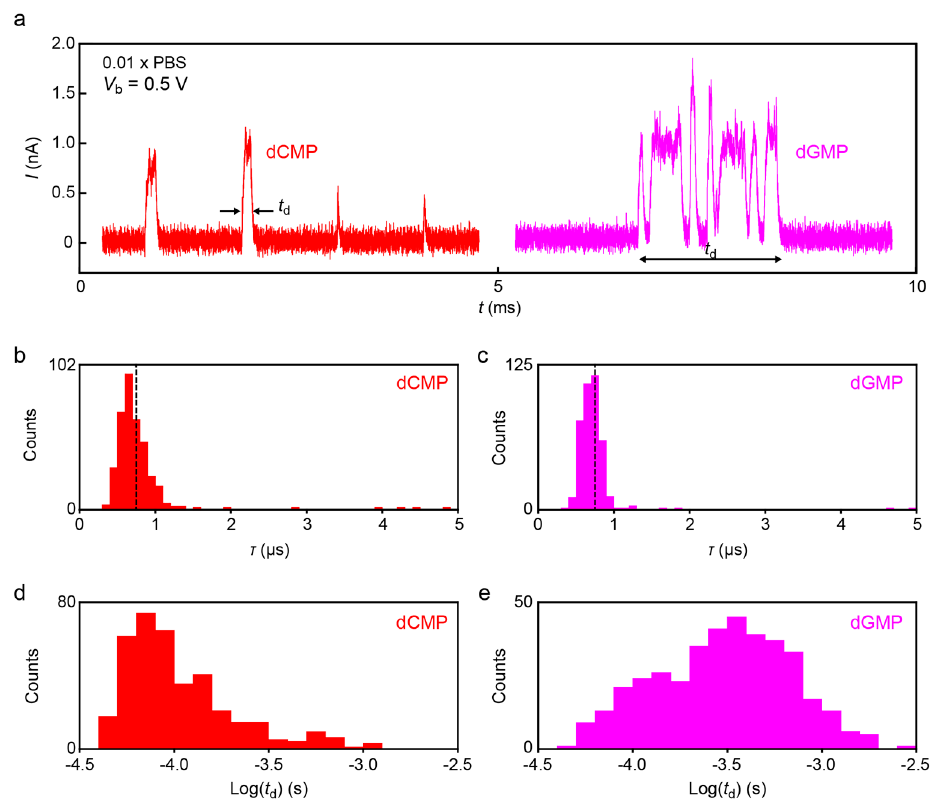
Figure 8. ( a ) Tunneling current spikes detected for dCMP (red) and dGMP (purple) in 0.01 × PBS at 1 MHz with a 1 MHz low ‐ pass filter; ( b , c ) Distributions of τ for dCMP ( b ) and dGMP ( c ) in 0.01 × PBS. Dotted lines denote the average τ in DMSO; ( d , e ) Spike width t d histograms for dCMP ( d ) and dGMP ( e ).